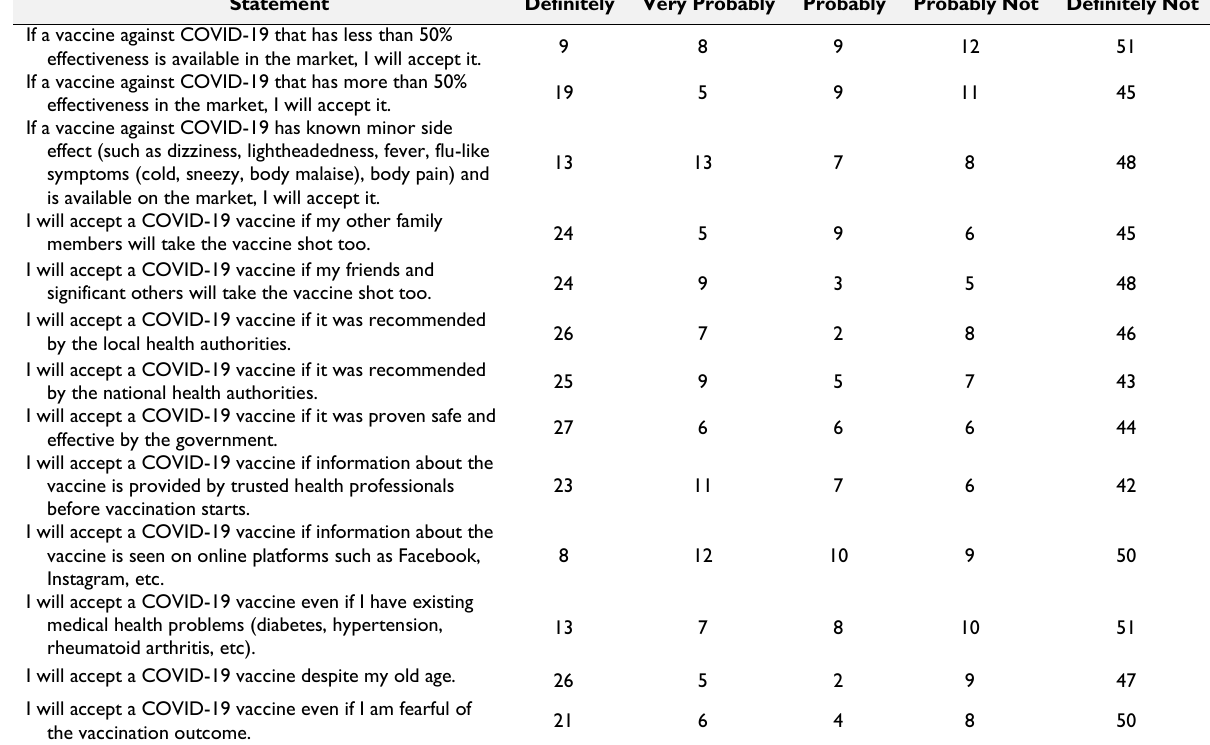
Table 2 COVID-19 vaccine